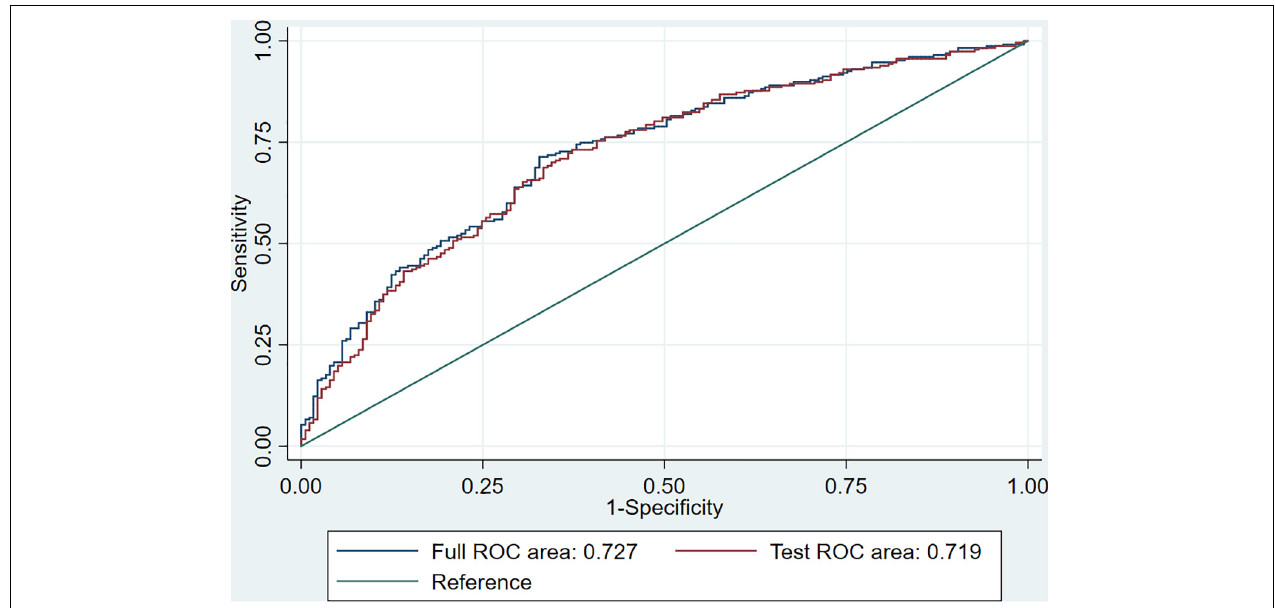
FIGURE 5 | ROC curve for 10-fold cross-validation. The full ROC area was 0.727, and the test ROC area was 0.719 for 10-fold